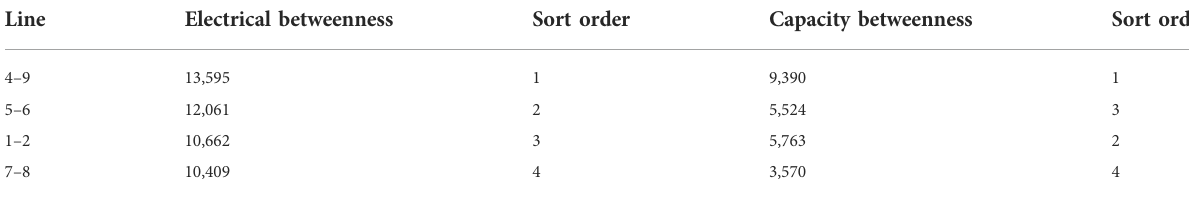
TABLE 3 Comparison between the IEEE14 node line electrical and capacity. Line